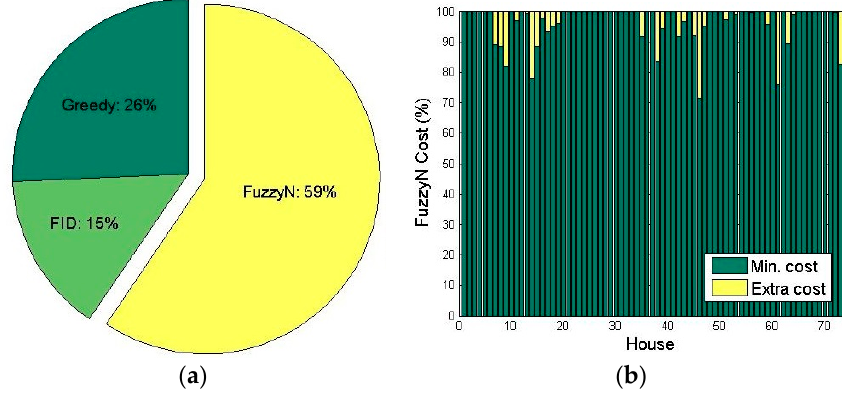
Figure 10. Simulated results ( a ) percentage of achieving lowest cost ( b ) improvement space for normal fuzzy (FuzzyN) compared to Greedy and feed-in damping (FID) methods.